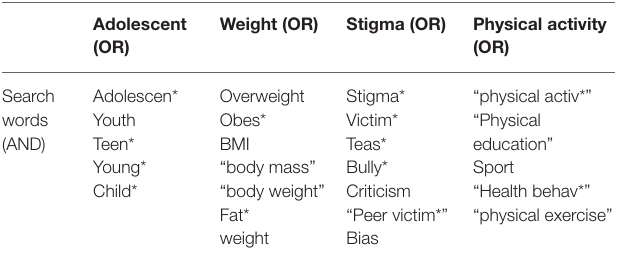
TABLE 1 | Search terms.